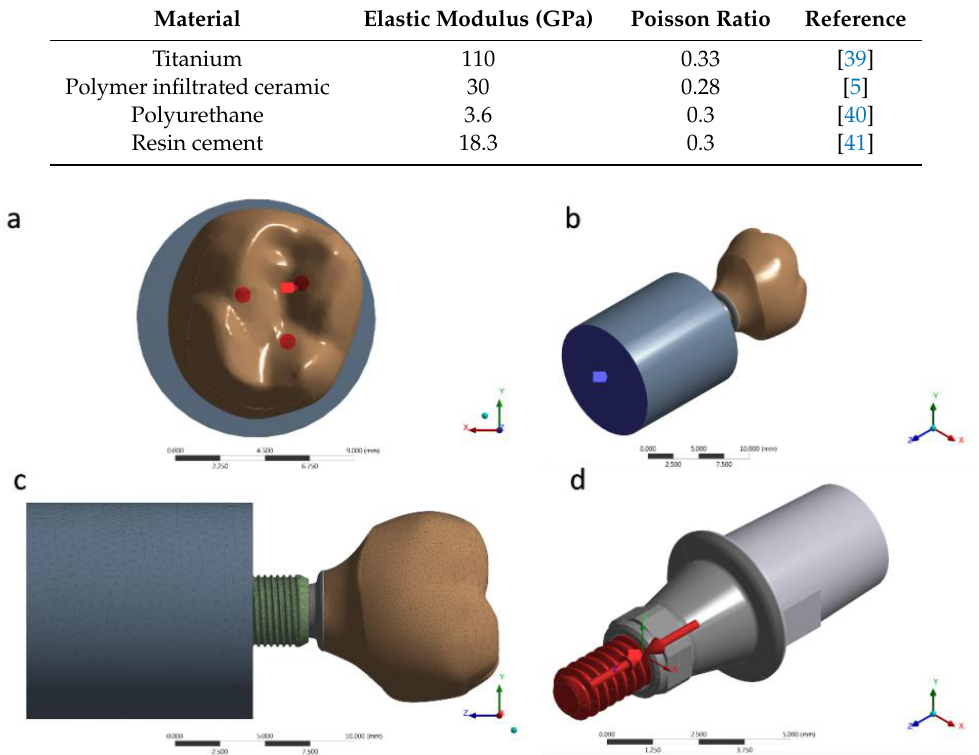
Figure 5. ( a ) Occlusal loading; ( b ) Fixing the system; ( c ) Mesh generated; ( d ) Pre-tension of 30